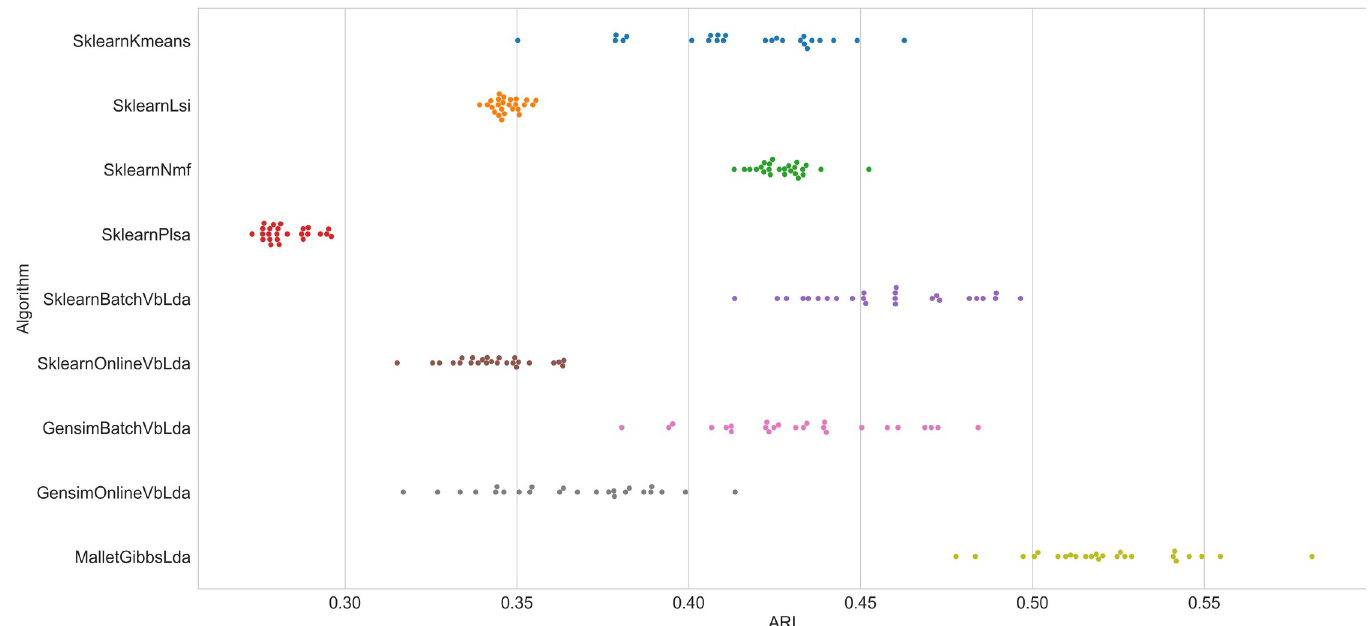
Fig 3. Algorithm performance (ARI) on the WikiA25 dataset.